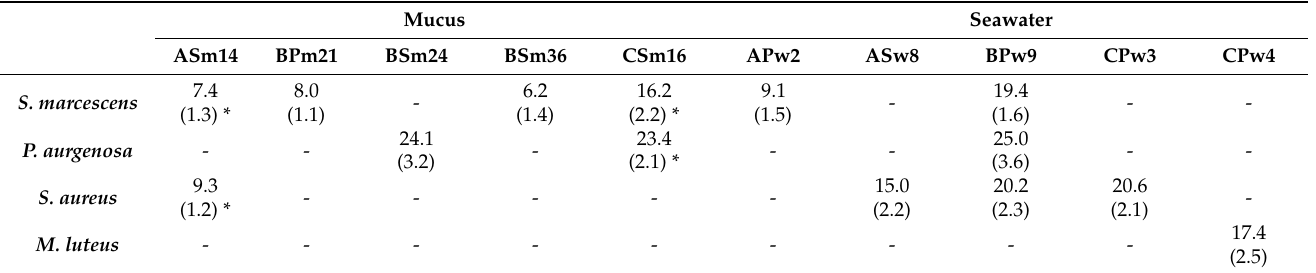
Table 3. Antibacterial activity of isolated strains from the coral mucus and the surrounding seawater.